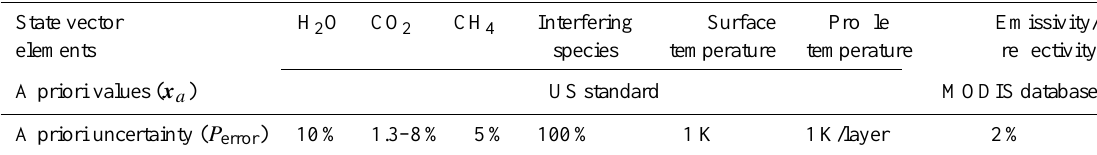
Table 1. State vector